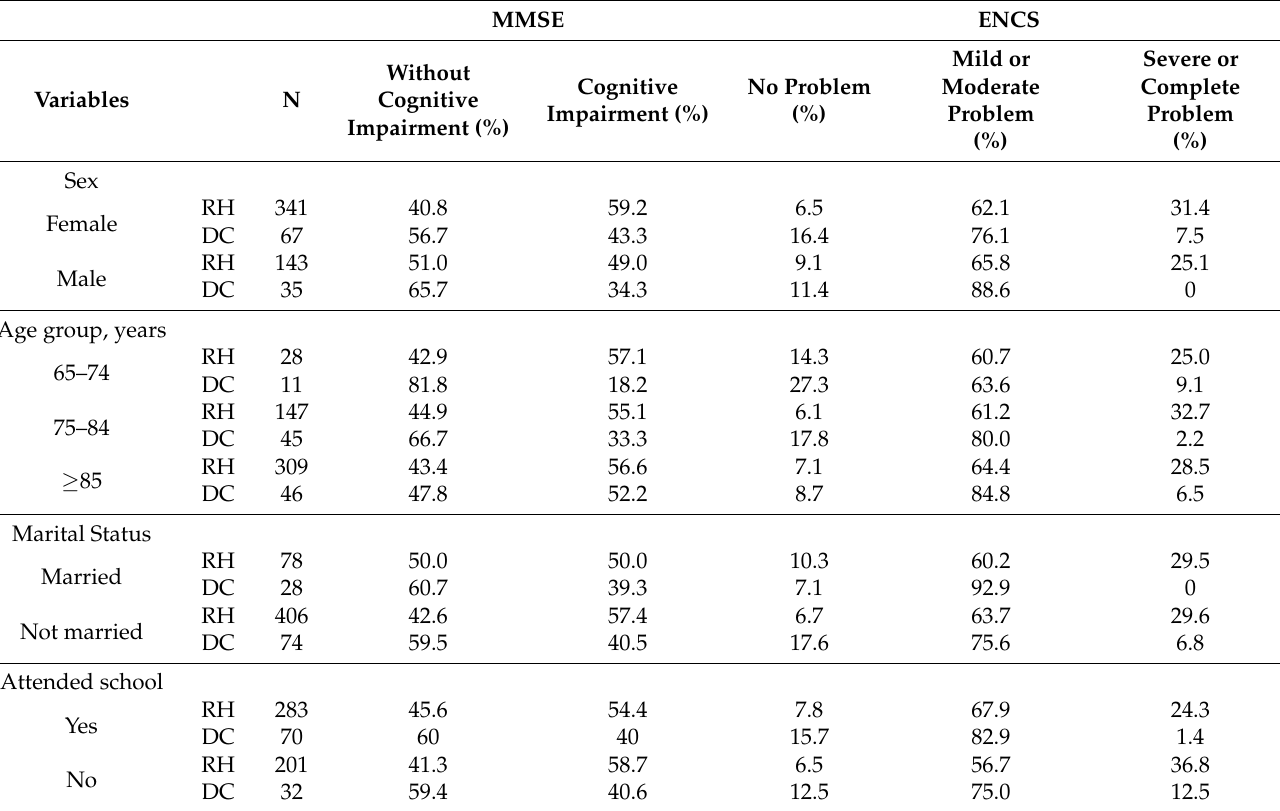
Table 3. Participants’ sociodemographic characteristics and general functioning profiles (N = 586). MMSE